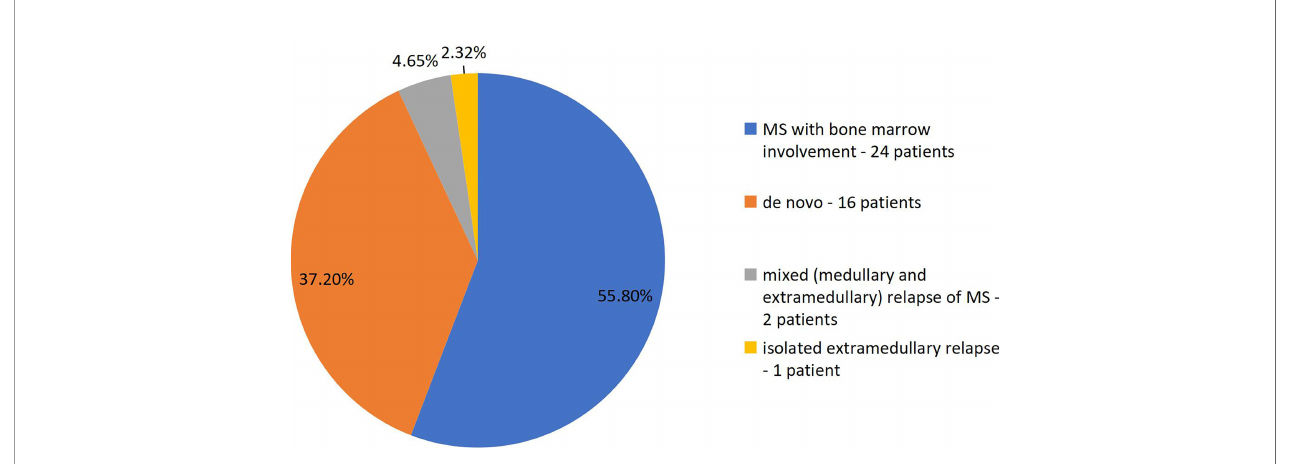
FIGURE 1 | Clinical presentations of myeloid sarcoma depending on the time relation to bone marrow